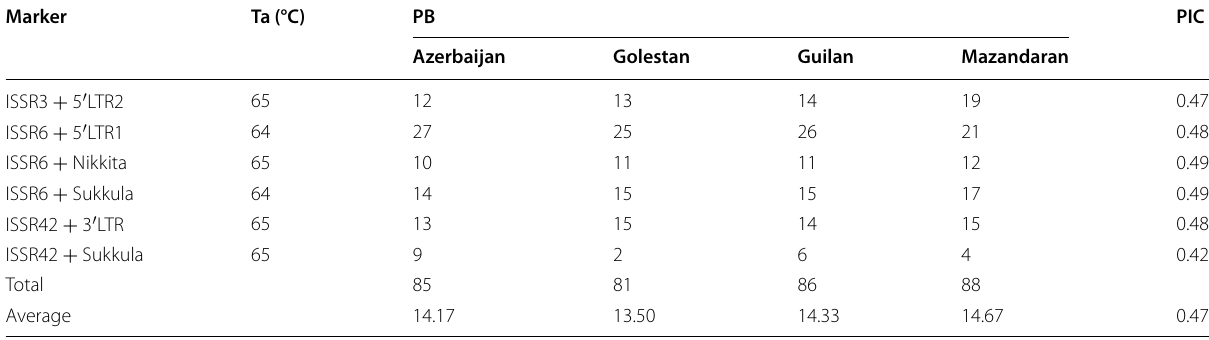
Table 3 Annealing temperature (Ta), number of polymorphic bands (PB), and polymorphic information content (PIC) for primer/ primer combinations in REMAP